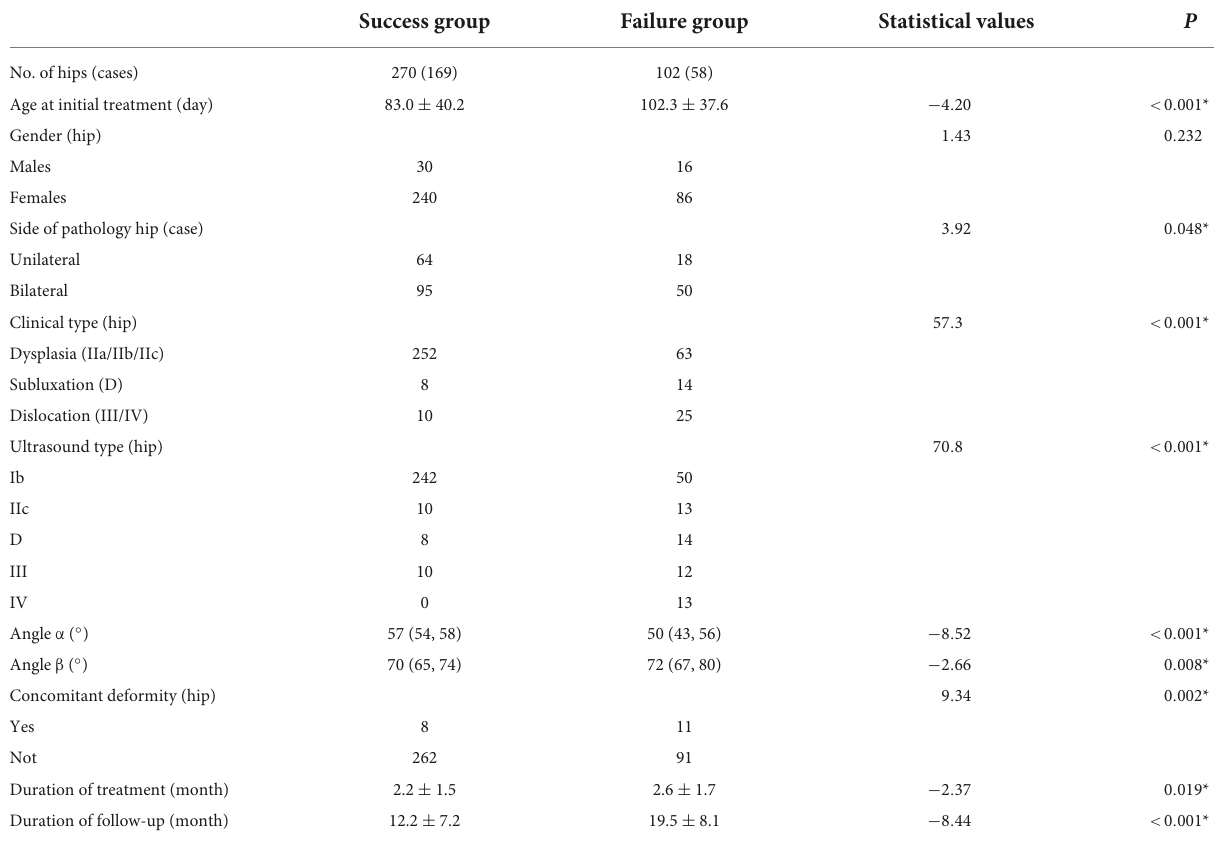
TABLE 1 Comparisons of clinical and imaging